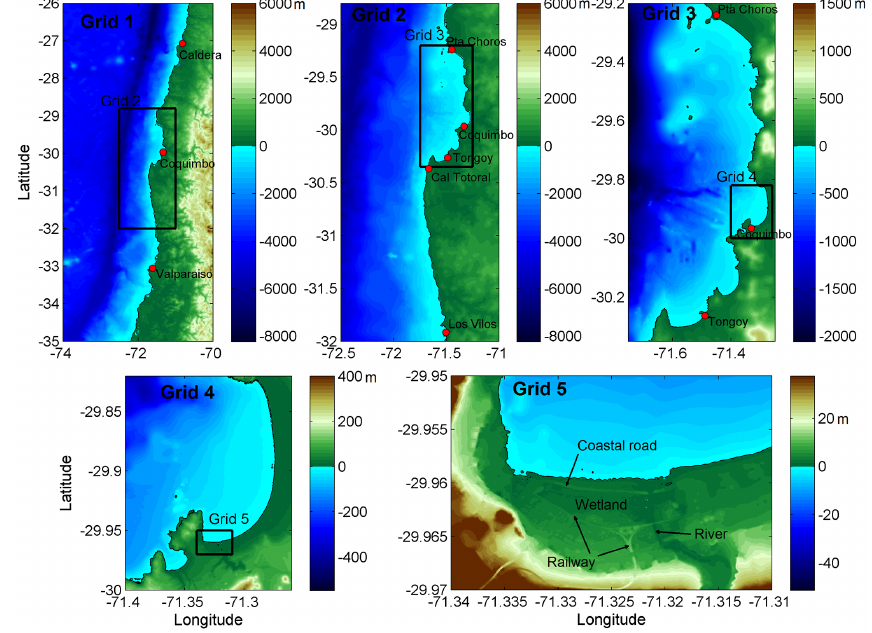
Figure 4. Model setting and nested computational grids for